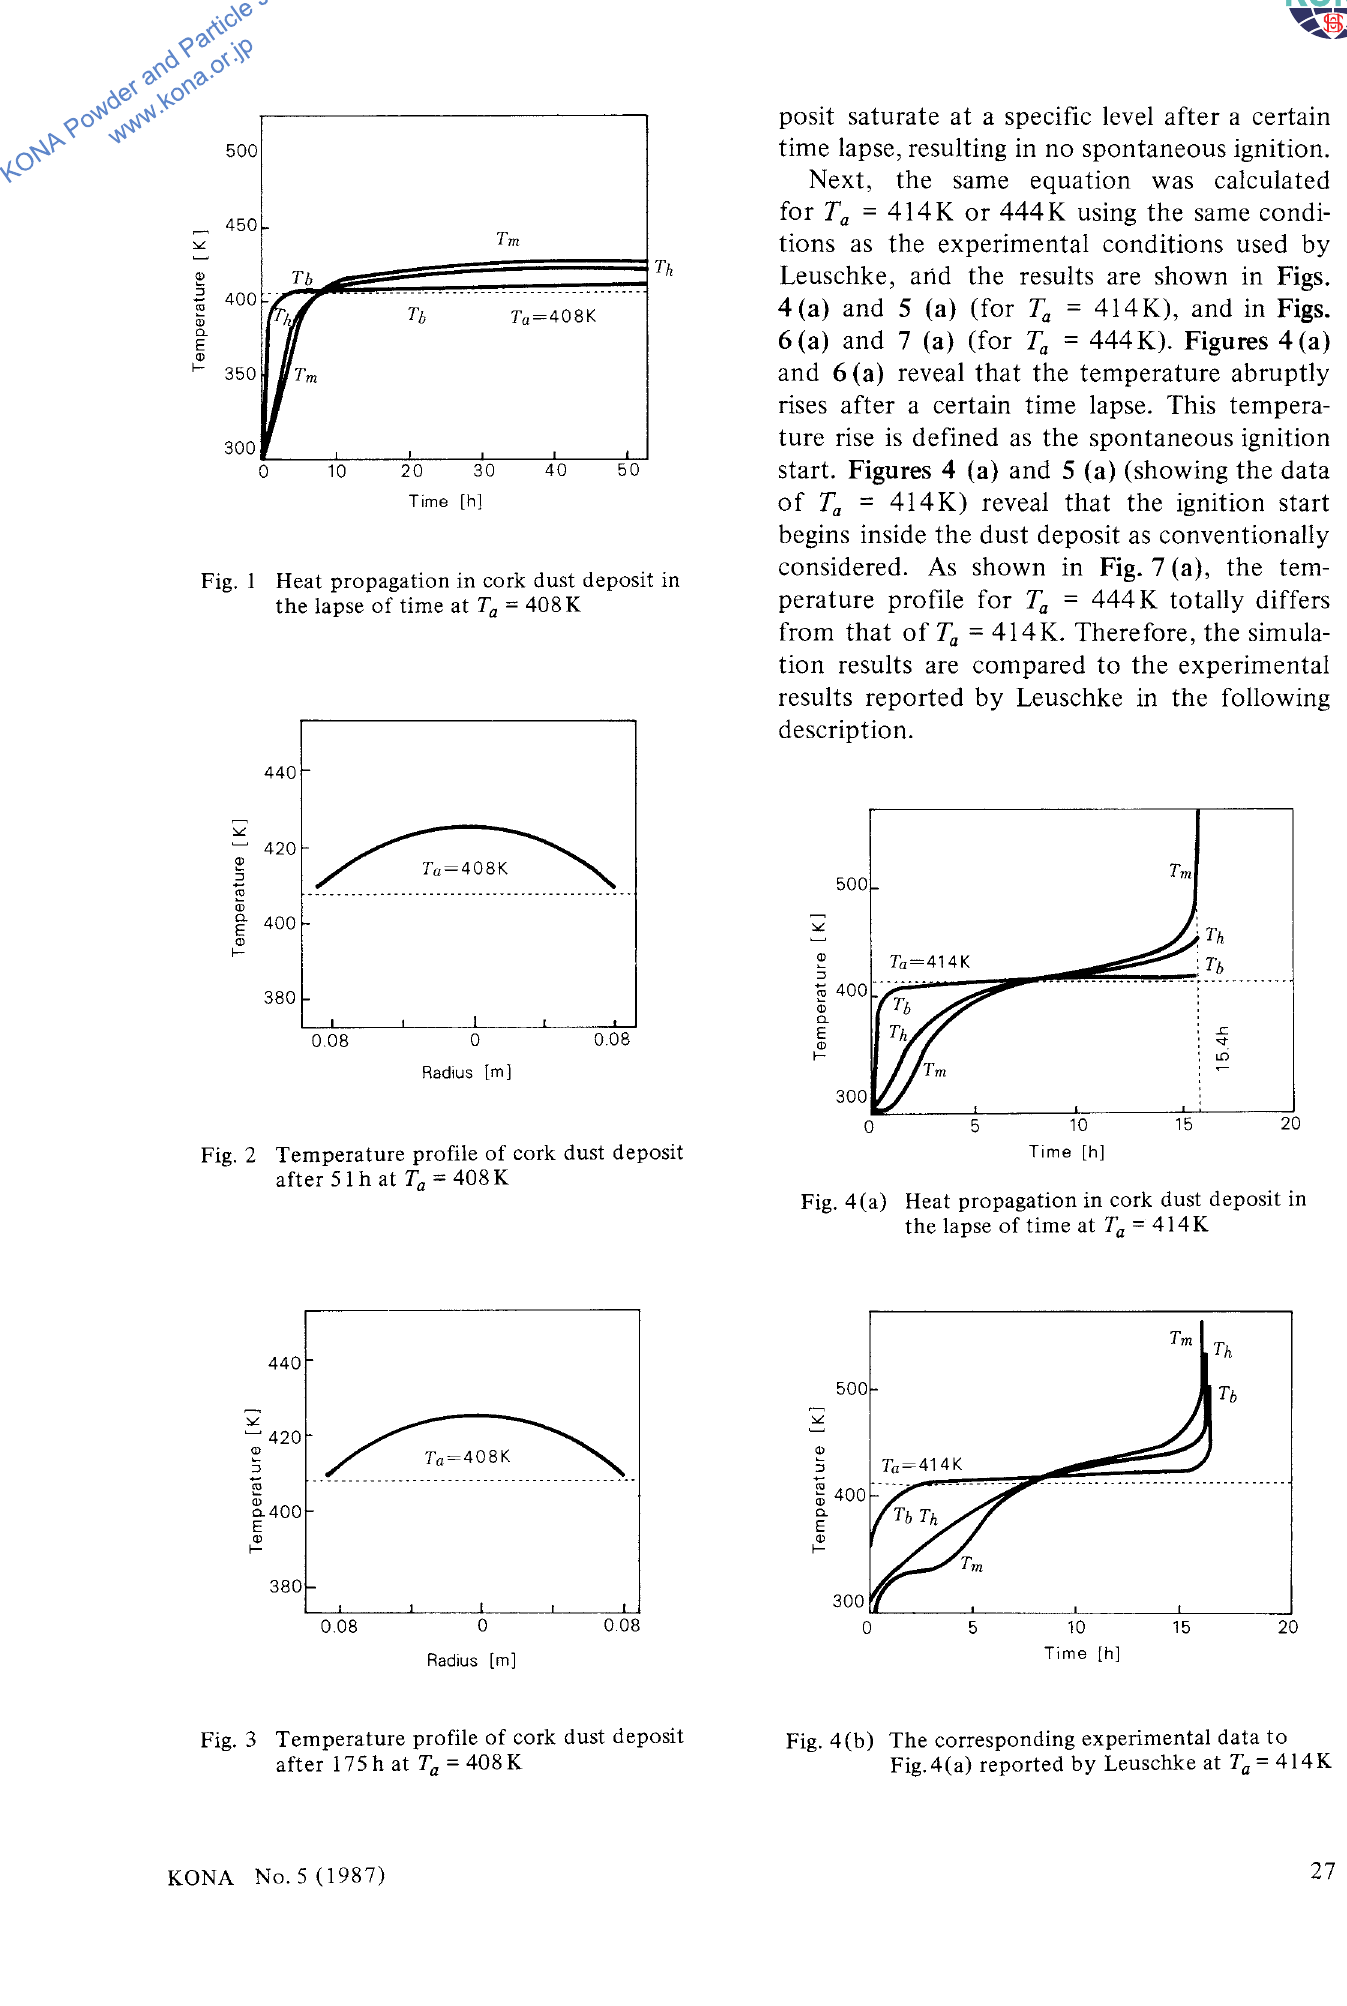
Fig. 4(b) The corresponding experimental data to Fig.4(a) reported by Leuschke at Ta =